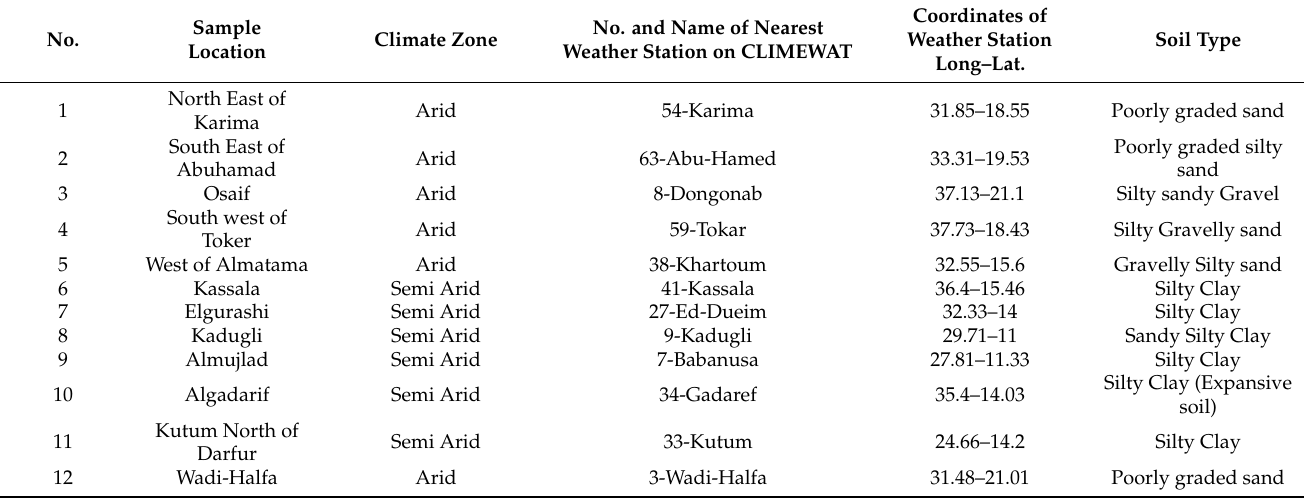
Table 1. Site locations and soil types (adopted from